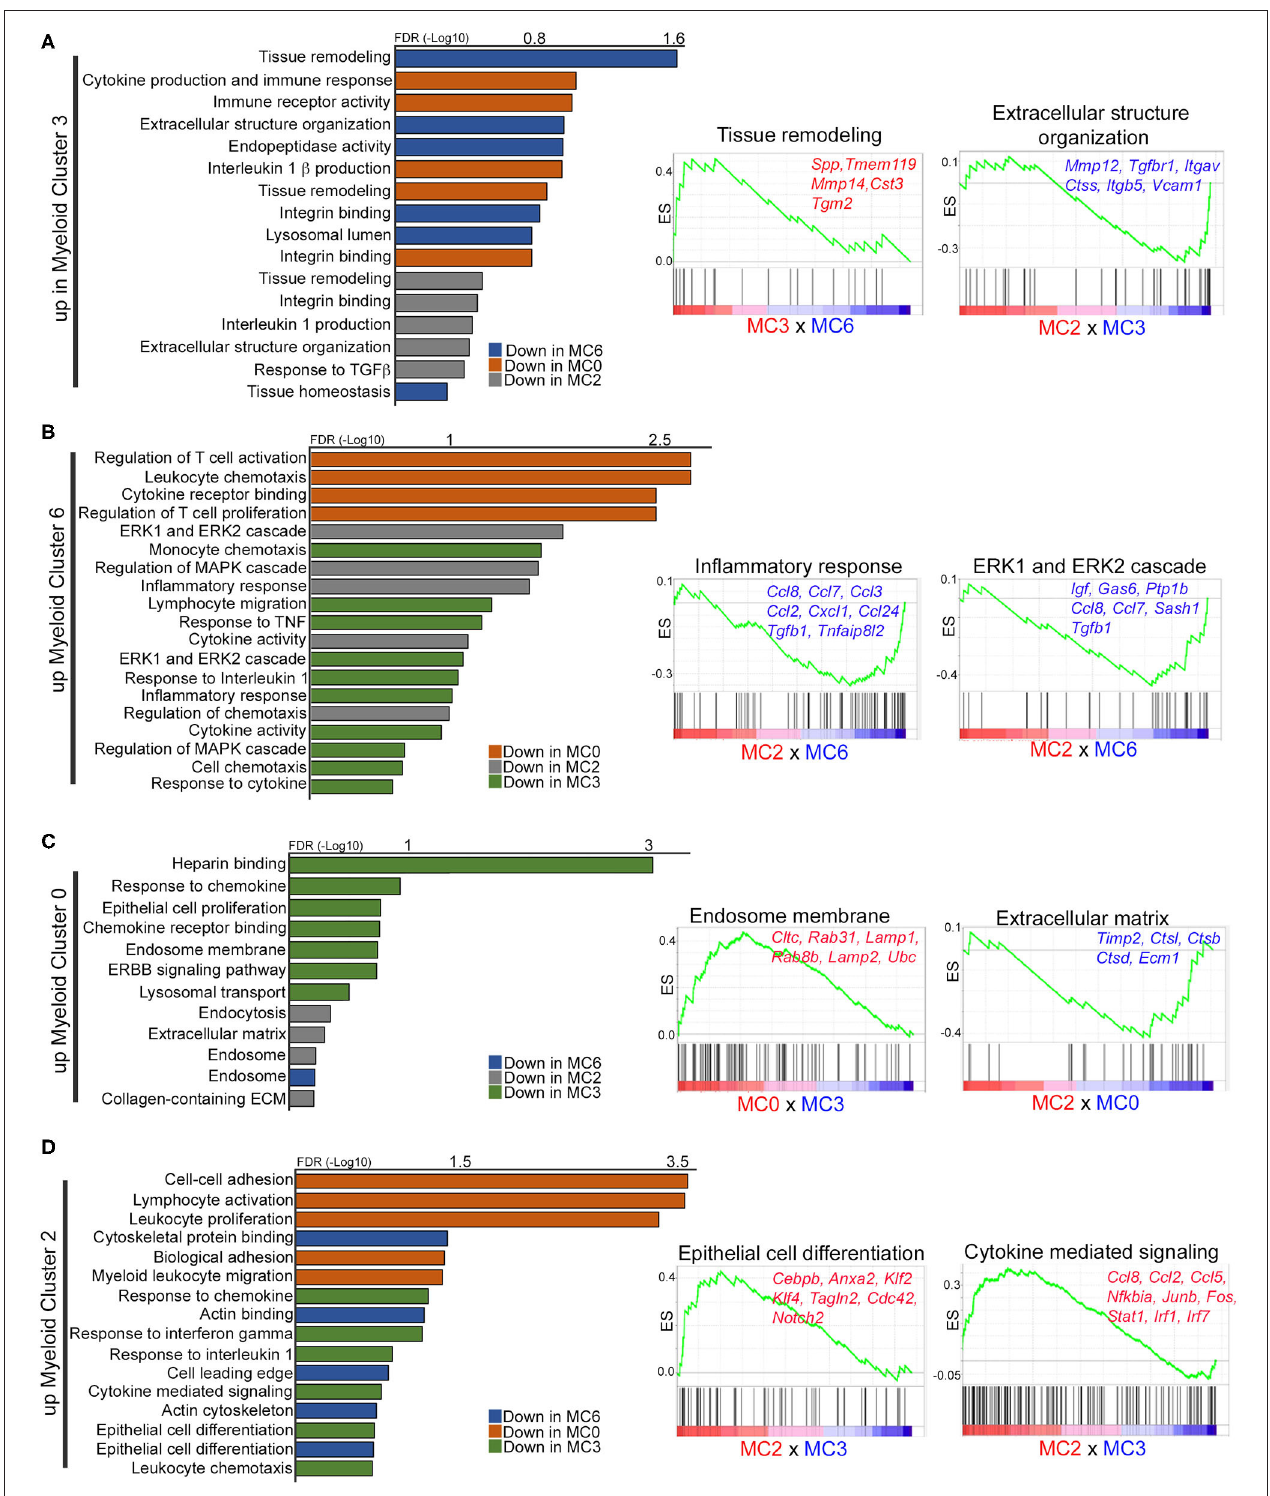
FIGURE 5 | Gene set enrichment analysis identifies unique gene ontology in macrophage subpopulations. (A–D) Graphs and enrichment plots show significantly changed gene ontology (GO) terms from GSEA analysis of each macrophage cluster compared to each other (MC0 × MC3, MC0 × MC6, MC3 × MC6, MC2 × MC0, MC2 × MC3, MC2 × MC6). Graphs depict GO terms that are increased (FDR < 1) in myeloid clusters 3 (A) , 6 (B) , 0 (C) , or 2 (D) . Enrichment plots illustrate selected significantly upregulated GO terms with representative genes that are significant.